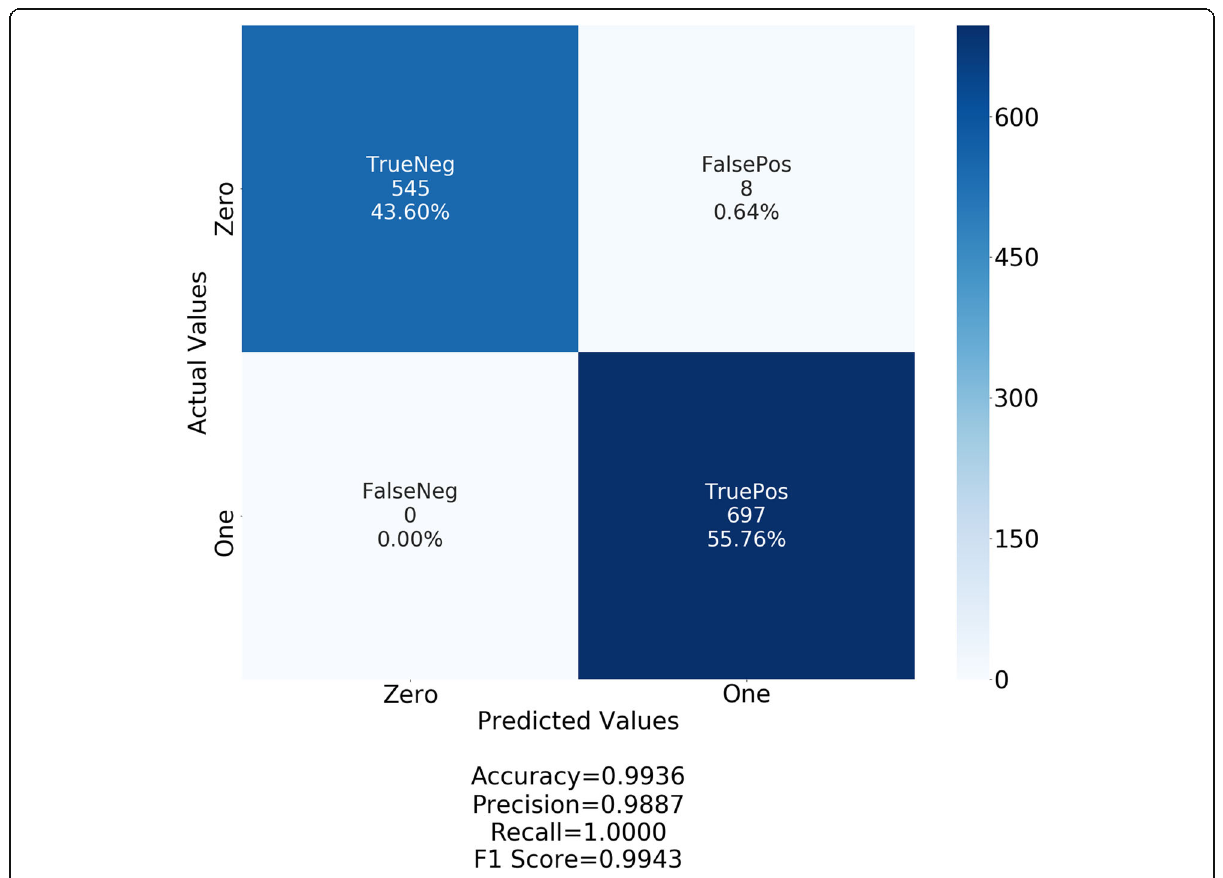
Fig. 6 Confusion Matrix Produced by the Trained